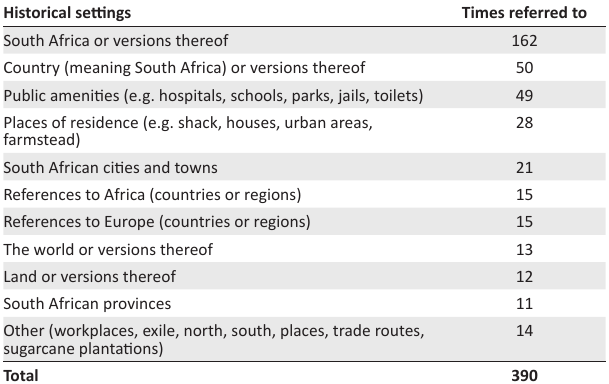
TABLE 2: Historical settings and times referred